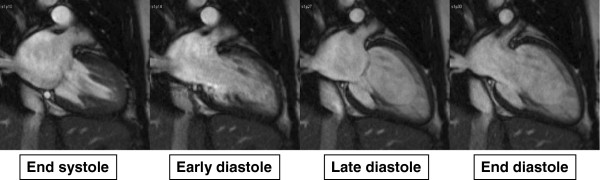
Illustrations of left atrial phasic changes on MR cine images during cardiac cycle when atrial size is at the largest during end systole and smallest during end diastole. The left atrial precontractile phase is determined at the late diastole when mitral valve is nearly closed before it opens again after atrial contraction.